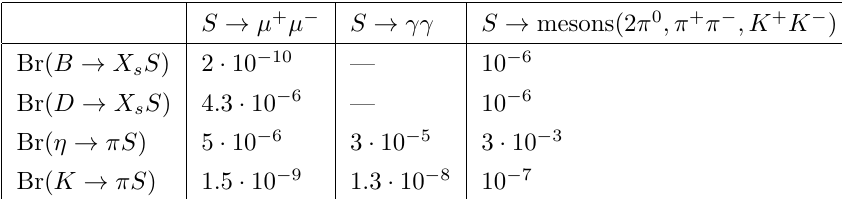
Table 1 . Upper limits on meson branchings into sgoldstino [18, 35, 46, 47].